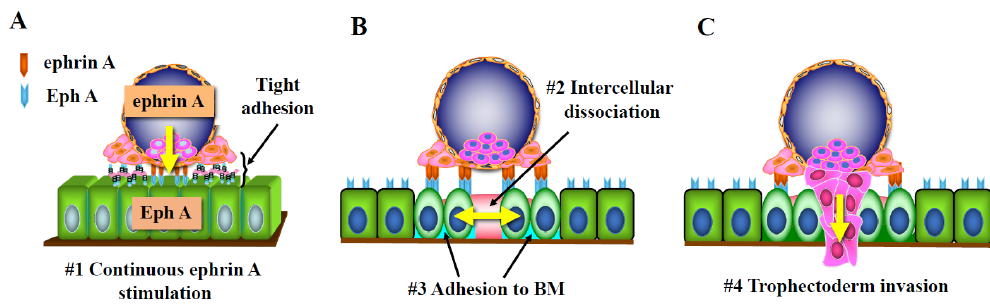
Figure 3. Possible mechanisms of human embryo invasion after attachment to endometrial epithelial cells. ( A ) After the embryo has firmly attached to the endometrium via several adhesion molecules, luminal epithelial cells receive continuous ephrin A signaling from the attached embryo (#1). ( B ) The Eph–ephrin system induces reduction of the tight junction of epithelial cells (#2), opening the epithelial cell layer (yellow two-way arrow). ( C ) This system also promotes cell attachment to the extracellular matrix (#3) without destroying the connection between the embryo-attached epithelial cells and the basement membrane (BM). ( D ) This system may promote migration of the activated trophectoderm (#4) into the intercellular spaces of epithelial cells with reduced tight